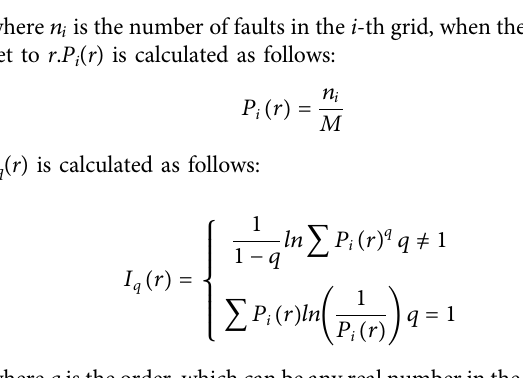
Frontiers in Earth Science |